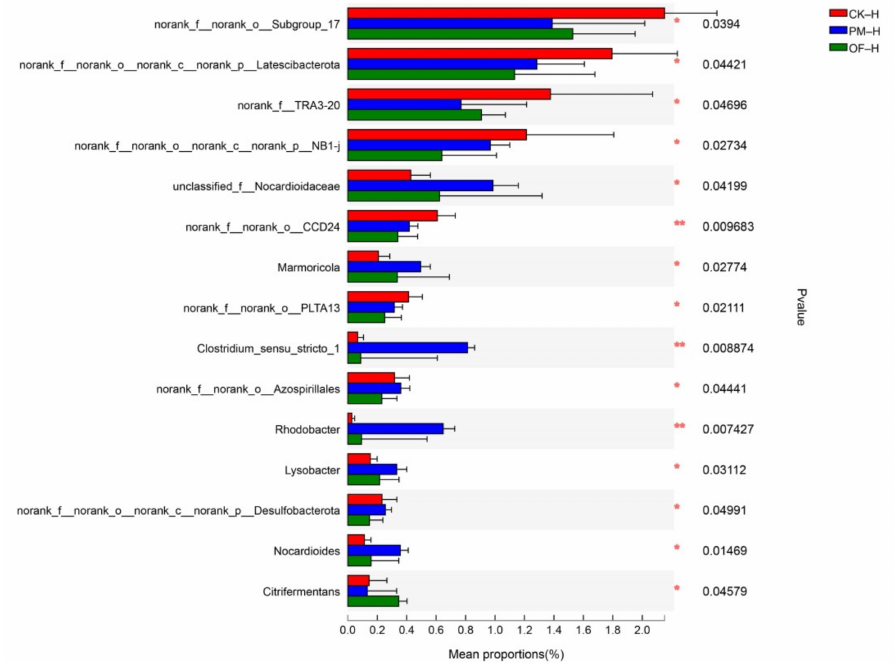
Figure 5. The comparison of differential bacteria between treatment tests based on the relative abundance at genus level during heading